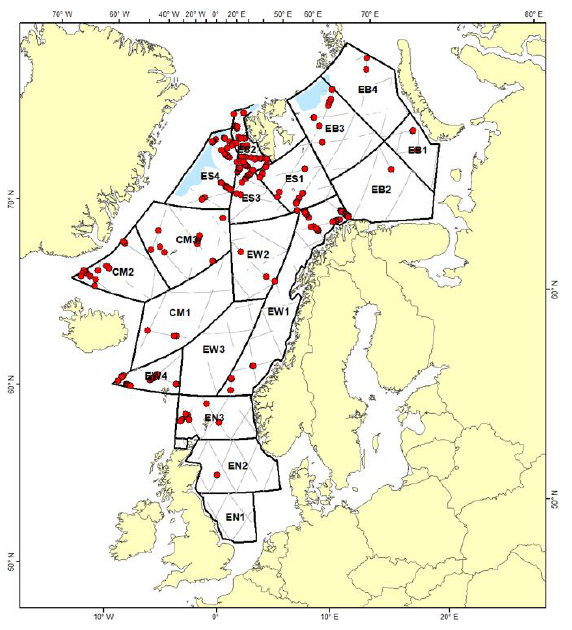
Figure 3. Distribution of sightings recorded as fin whales during the 2014 – 2018 sighting surveys. The blue areas represent ice coverage. Humpback whales Humpback whales were sighted in 3 key areas: the northern Barents Sea (EB3); around Bear Island (ES1); and north and east of Iceland (CM2, CM3). Figure 5 shows the distribution of humpback whale sightings. The DS detection function was fitted with a hazard-rate key function to data truncated at a distance of 3000 m, which resulted in an estimated p (0)=0.76 (CV=0.07) and eshw of 1087 m. Figure 4b illustrates the fitted DS detection function and conditional detection function (MR model). Total corrected abundance of humpback whales was estimated to be 10,708 (CV=0.38, 95% CI: 4,906 – 23,370). Abundance and density estimated by survey block are detailed in Table 7.